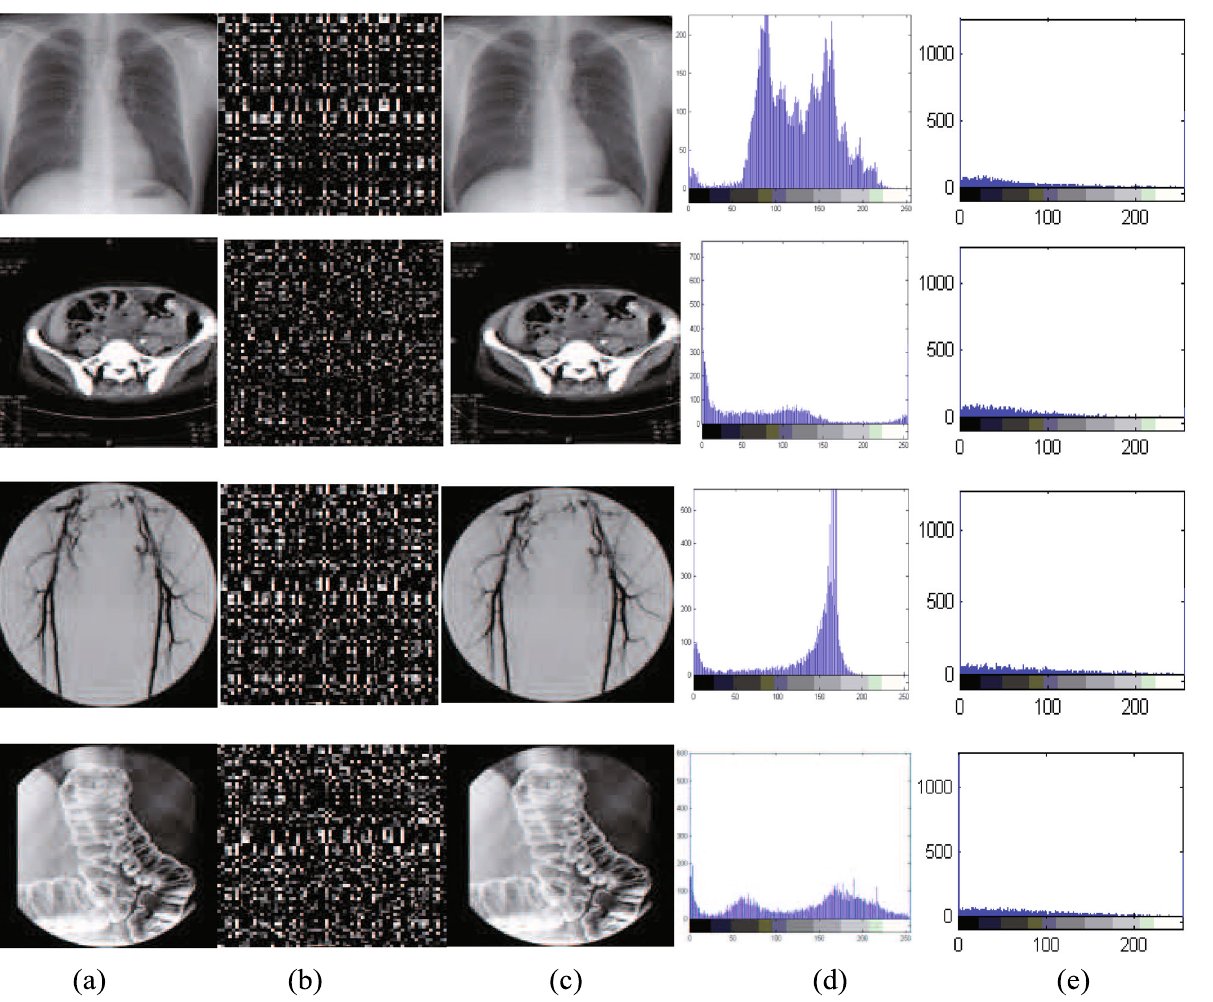
Fig. 4 Medical images encryption results: ( a ) Original medical images, ( b ) Encrypted medical images, ( c ) Decrypted and fingerprinted medical images, ( d ) Histograms of the original medical images, ( e ) Histograms of the encrypted